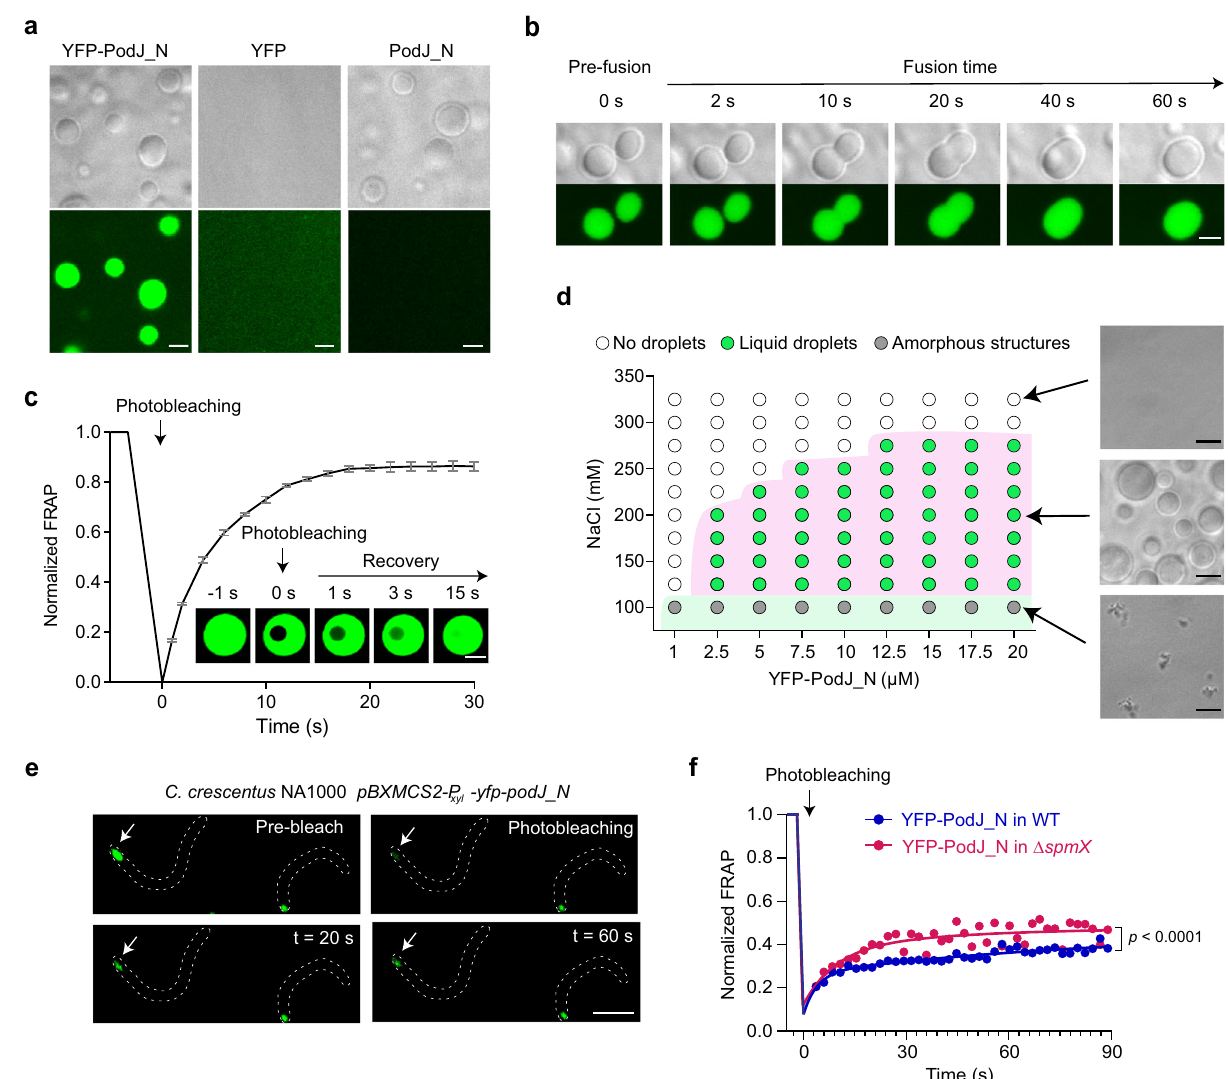
Fig.2|PodJundergoesphaseseparationbothinvitroandin C.crescentus .a The YFP-PodJ_N protein forms liquid droplets in vitro. Images were taken within 15min afterloadingtheice-bathedproteins(5 µ M)onaglasspadat25°C.YFPwasusedas a negative control. b The instantaneously contacted YFP-PodJ_N droplets tend to fuse together within 1min. c FRAP analysis suggests that YFP-PodJ_N droplets are highlydynamic.TherecoverycurvewasgeneratedbyaveragingthesignalsofYFP- PodJ_N droplets ( n =6) from three independent experiments. One representative droplet is shown. The fl uorescence intensity of pre-bleached droplets was nor- malized as 100%. Data are means±SEM. d A regime diagram illustrates the for- mation of YFP-PodJ_N droplets at different protein and salt concentrations.